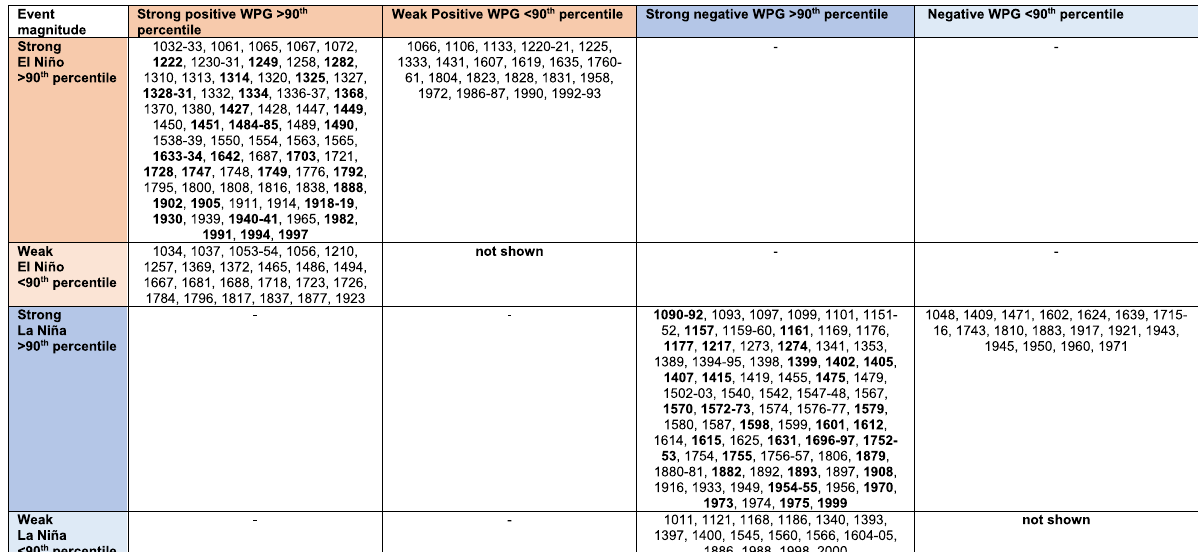
Table 1. Extreme events in PHYDA based on 90th percentile of normalised and detrended indices illustrated in Fig. 4. Time series were normalised relative to 1961–1990. Simultaneous extreme events in WPG and Niño3.4 indices based on the 95th percentile marked in bold letters. Negative WPG events <90th percentile co-occurring with strong La Niña are also indicated. Weak positive WPG events < 90th percentile co-occurring with strong El Niño events in the PHYDA reconstruction are also